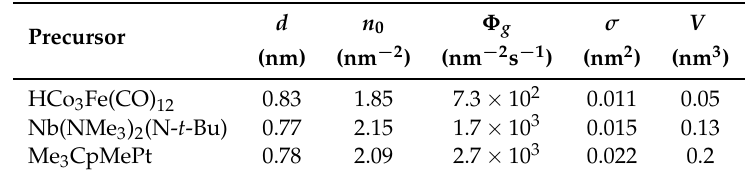
Table 1. Table of precursor-specific parameters used to deduce E A and κ 0 by employing Equation (5): d is the average precursor molecule diameter from which n 0 is calculated as n 0 = 1/ π ( d /2 ) 2 . The volume of the deposit per dissociated precursor molecule V was calculated from average densities and molar masses using the deposit compositions as measured in independent X-ray spectroscopy (EDX) experiments. The cross sections are taken from References [21,22] for the Pt- and CoFe-precursor, respectively. For the Nb-precursor, the cross section is not known and was estimated, as typical cross sections are between 0.01 and 0.02nm 2 for focused electron beam-induced deposition (FEBID) precursors